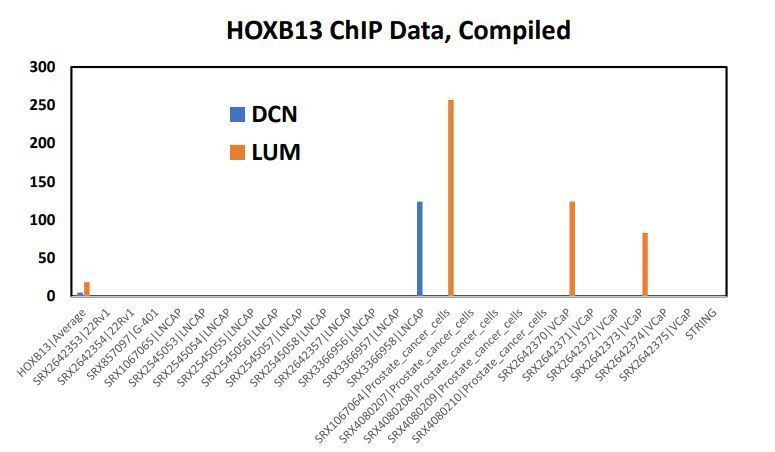
This file contains the HOXB13 binding to DCN and LUM of every publicly available HOXB13 ChIP-seq experiment done in prostate tissue or cell lines.Every column is a different study or different treatment condition from the same study. The SRX###### number at the top of each column to be taken to more info about the study/experimental design for that HOXB13 ChIP run. The numbers for everything reflect the HOXB13 peak intensity (high number = more confident peak).